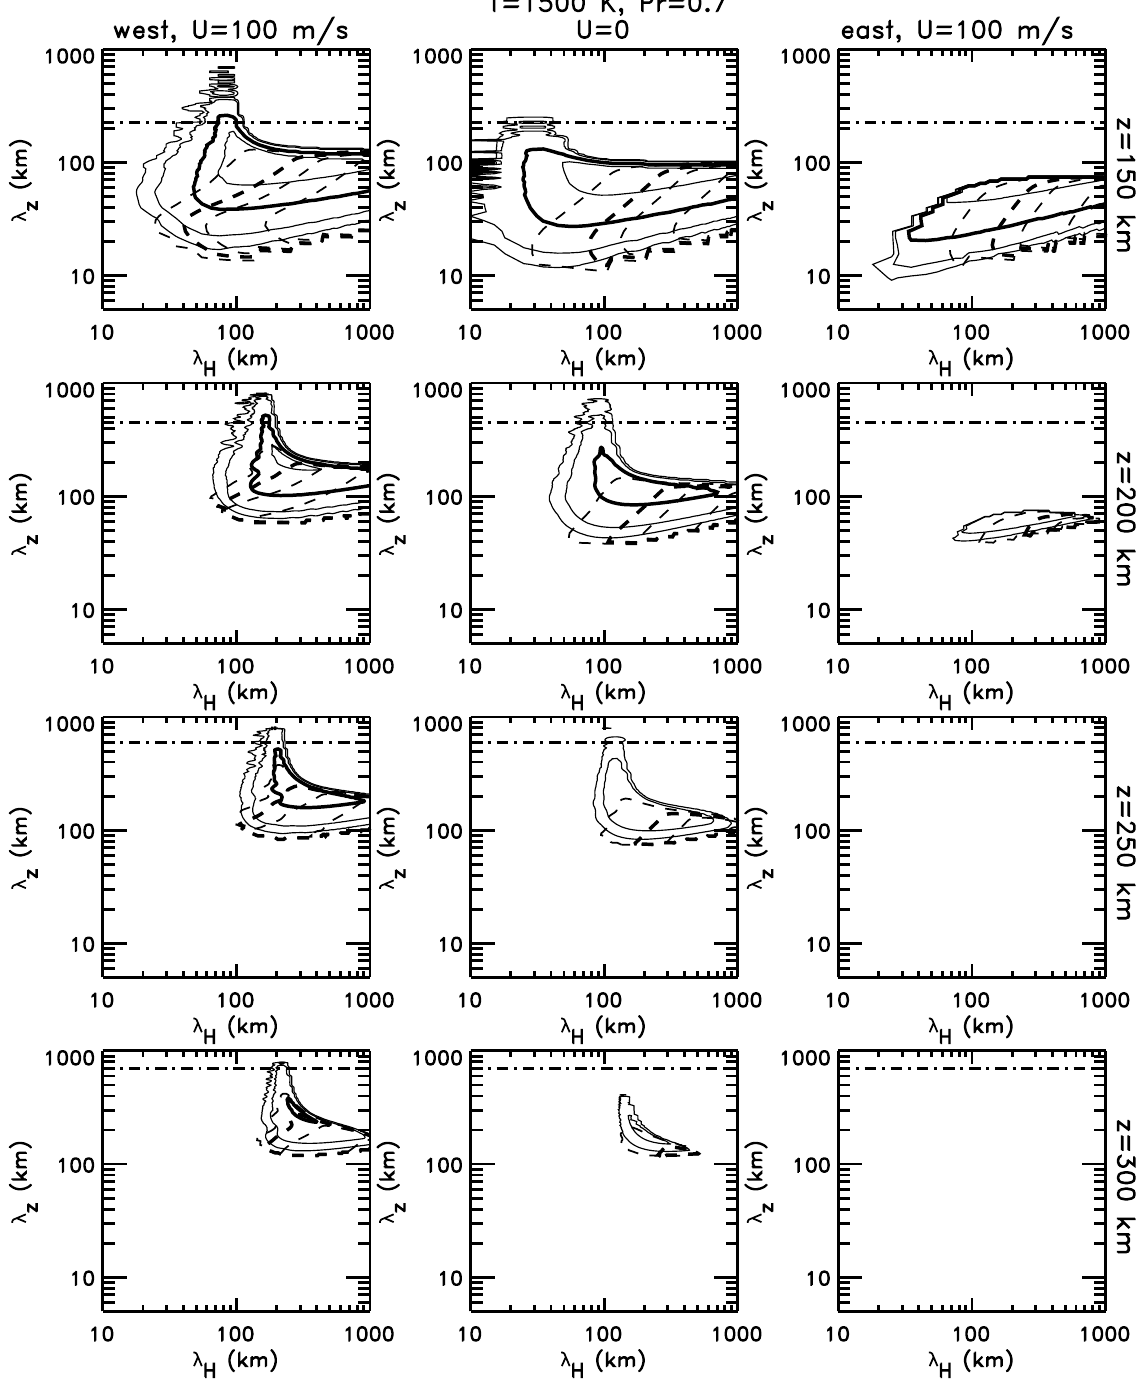
Fig. 8. As in Fig. 6, but for maximum solar forcing conditions ( ∼ 1500K thermospheric temperature).